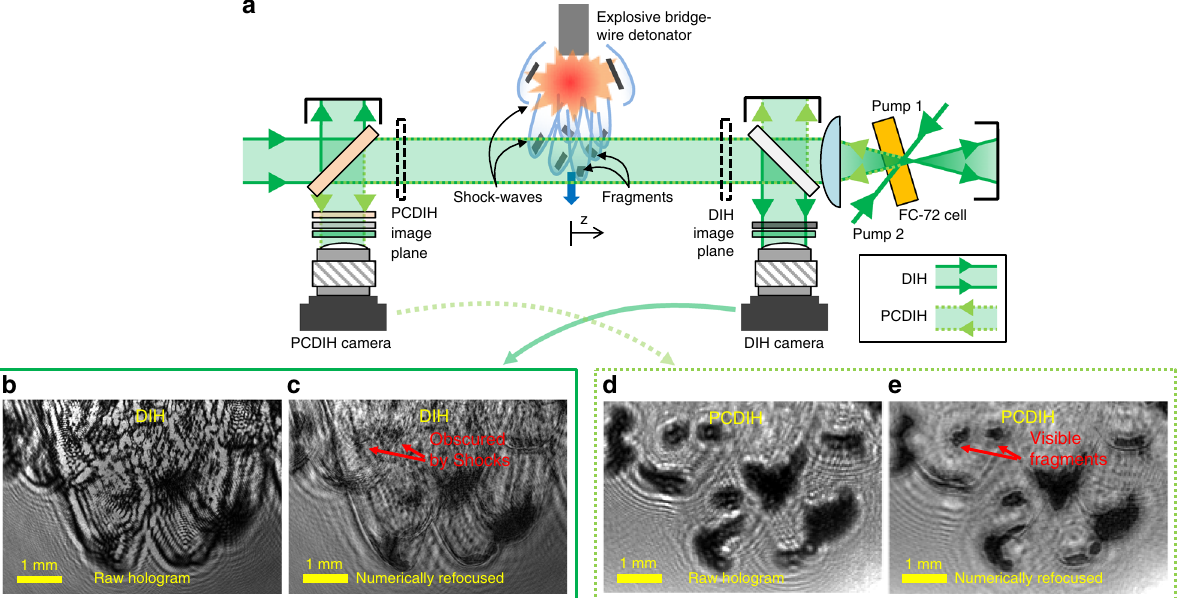
Fig. 1 Phase conjugate digital in-line holography measurements. a Simpli fi ed setup for simultaneous DIH and PCDIH for imaging of explosively generated hypersonic fragments is illustrated. Raw and numerically refocused DIH images b and c are shown with the raw and numerically refocused PCDIH images d and e of hypersonic fragments surrounded by shock-wave distortions. These numerically refocused images taken with a picosecond laser show how PCDIH successfully cancels phase distortions that obscure